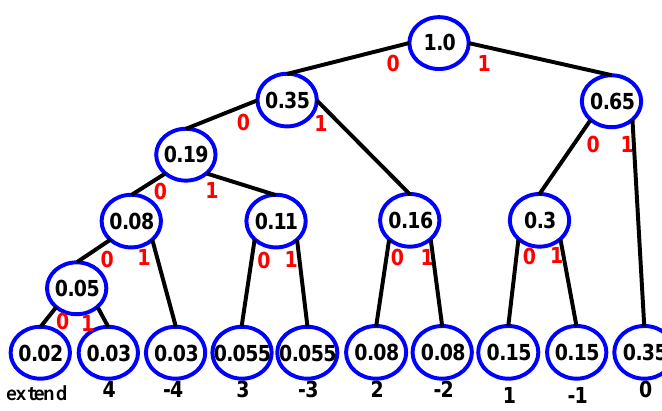
Figure 7. The Huffman coding